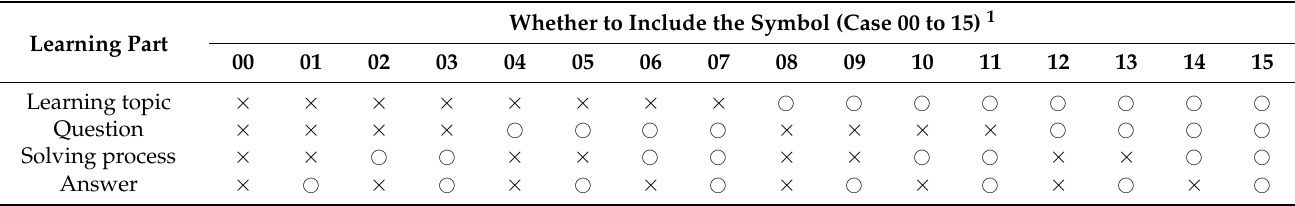
Table 5. Classification of LC data according to whether the symbol is included in each learning part.